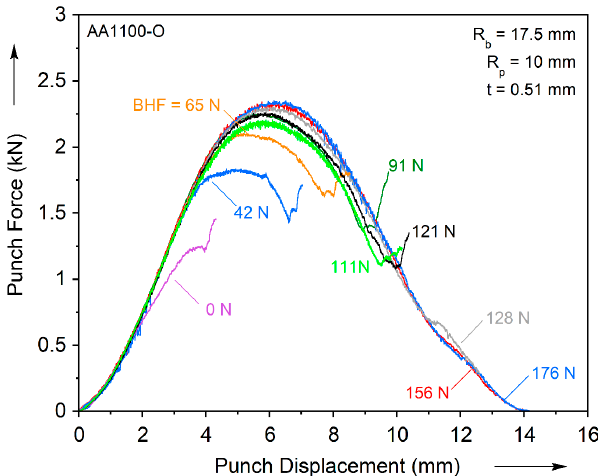
Figure 5. Recorded punch force-displacement responses for cups drawn under different BHFs. Some of the responses show a characteristic low valley and 2nd rise of the punch force, indicating ironing of the wrinkles that have previously formed in the